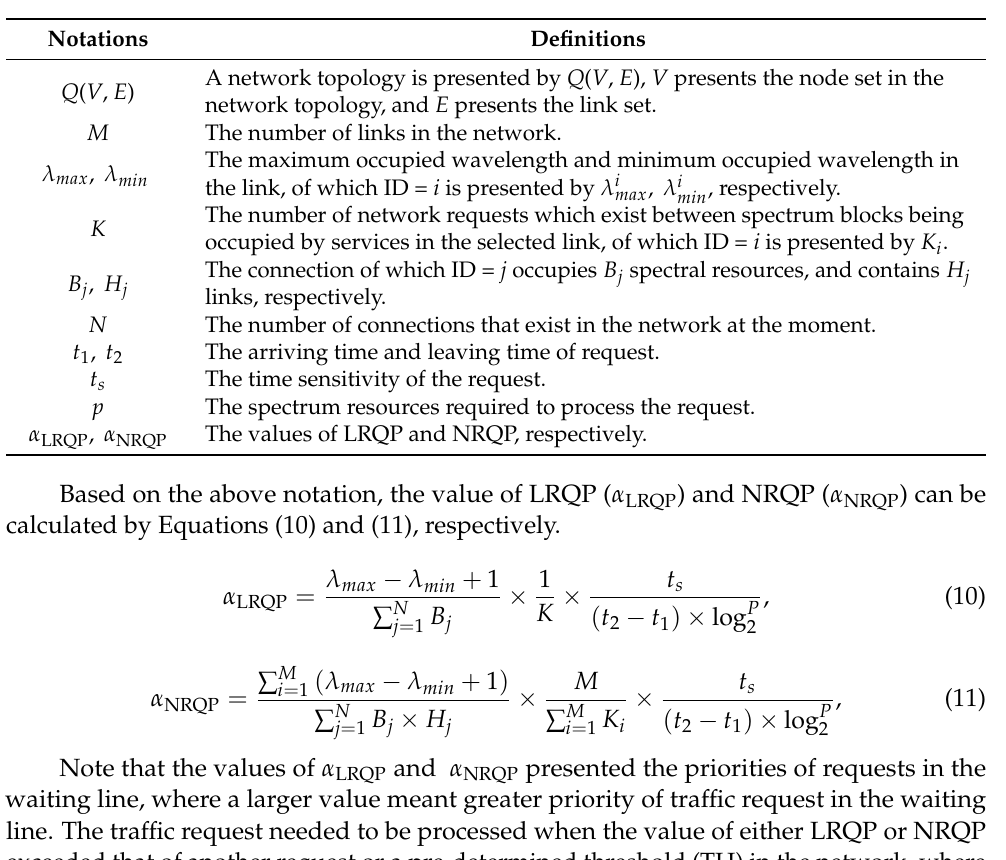
Table 1. Notations and definitions for LRQP and